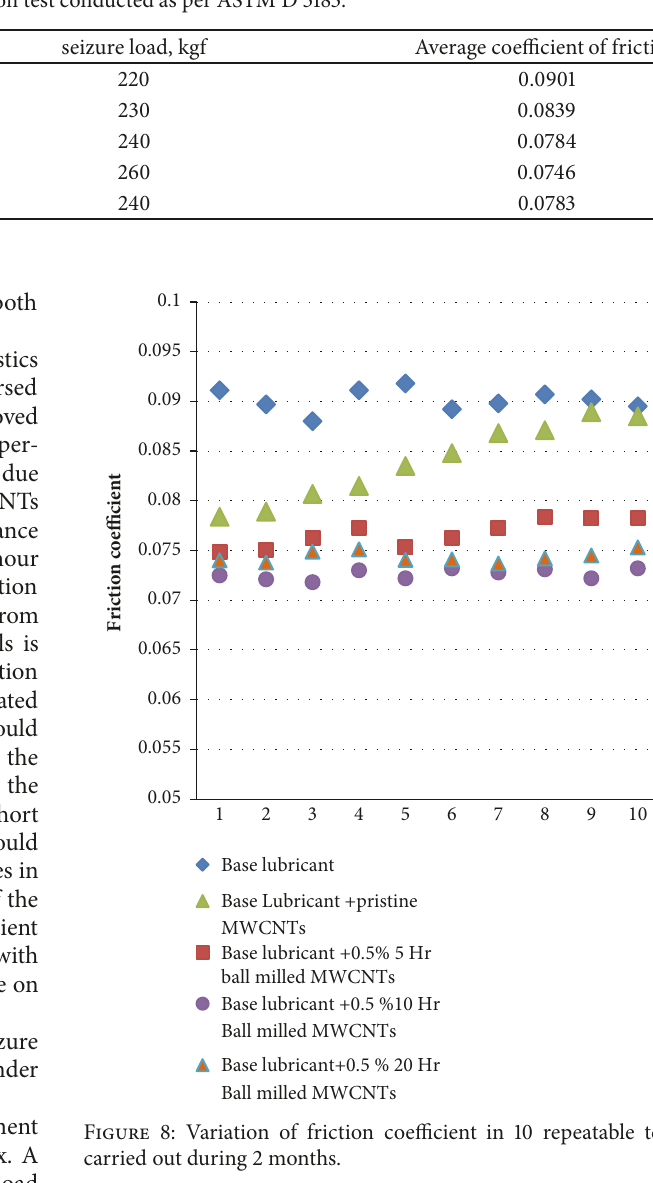
Table 5: Results of friction test conducted as per ASTM D 5183.